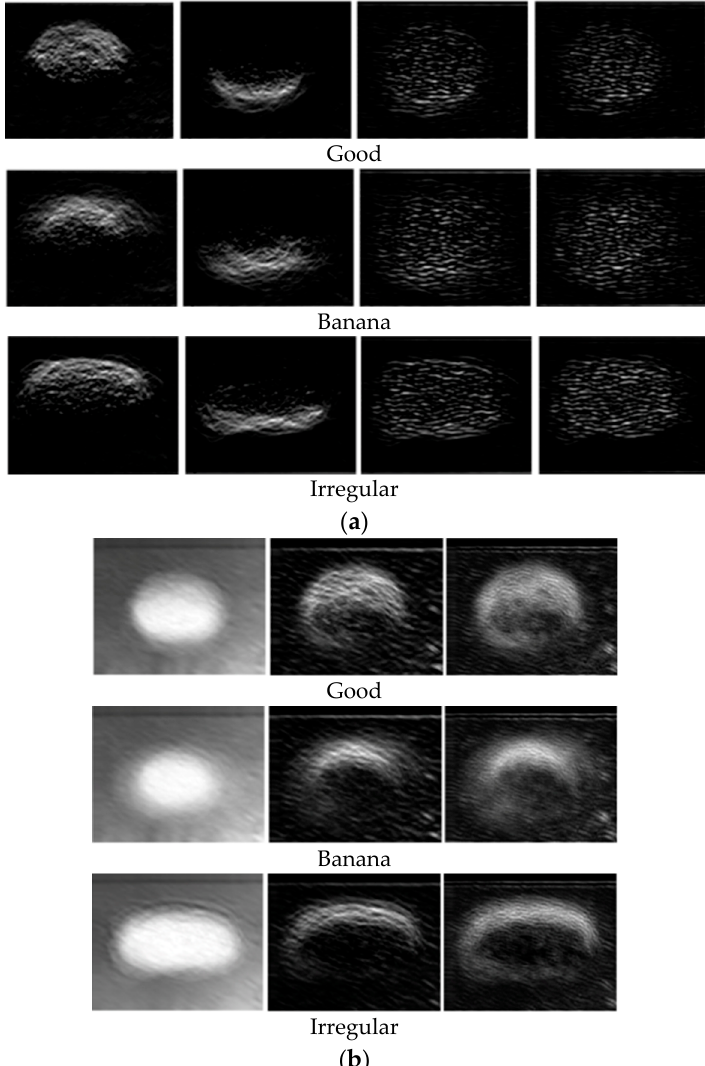
Figure 15. Visualization of two sample features that consist of ( a ) four transforms and ( b ) three transforms.